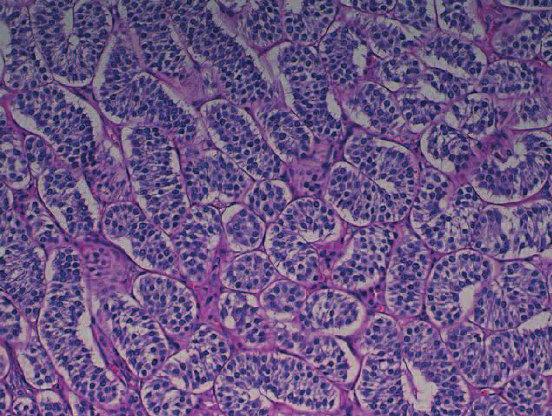
Figure 3. Left gonad in left inguinal orifi